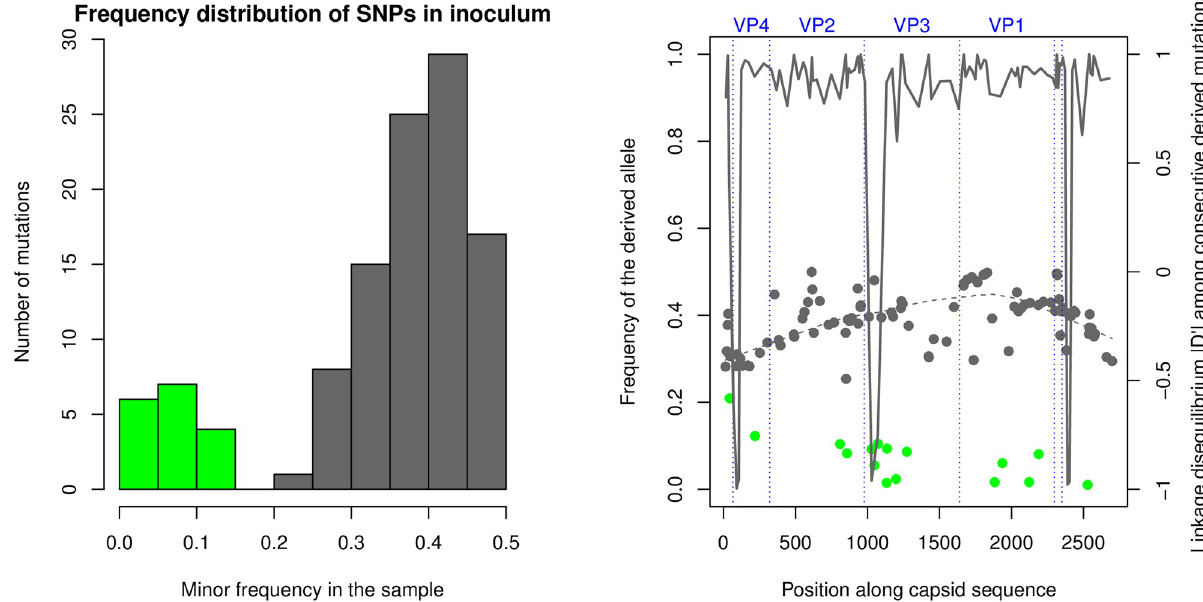
Fig 2. A: Distribution of minor SNV frequencies in the reads from the inoculum. The distribution is clearly bimodal, separating subpopulation-specific SNVs with minor frequency > 0.2 (grey) from intra-swarm ones (green). B: Location and frequency of the derived allele of SNVs, both subpopulation- specific (grey points) and intra-swarm (green points). The dashed line is the LOWESS of subpopulation-specific SNVs. The continuous line shows the linkage disequilibrium D 0 between pairs of consecutive derived variants.